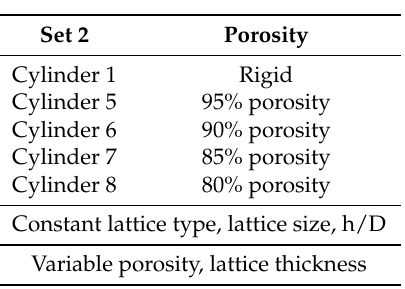
Table 2. Cylinders for experiment set 2.